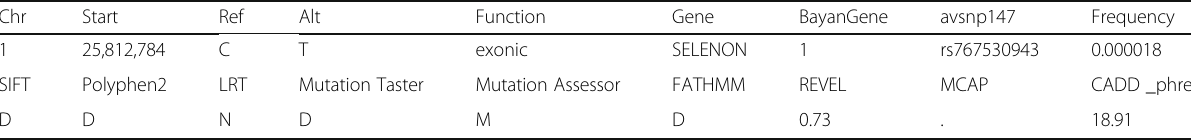
Table 2 Results of bioinformatics analyses of the novel mutation in this study